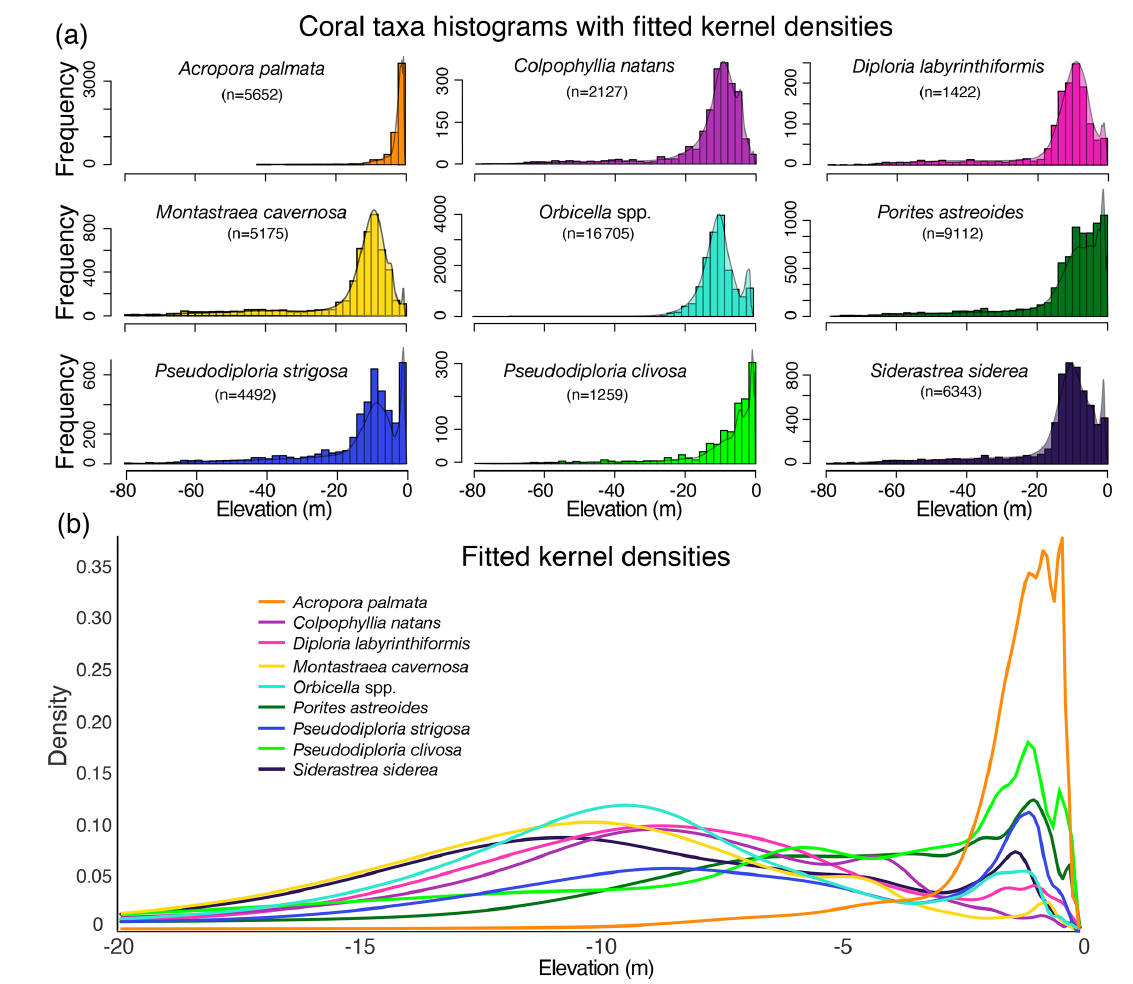
Figure 3. Empirical elevation distributions of the nine coral taxa used in the statistical model: (a) histograms of the modern occurrences of the taxa by depth (negative elevation) with kernel densities overlaid (note that frequencies are not on the same scales), and (b) the fitted kernel densities for each taxon on the same